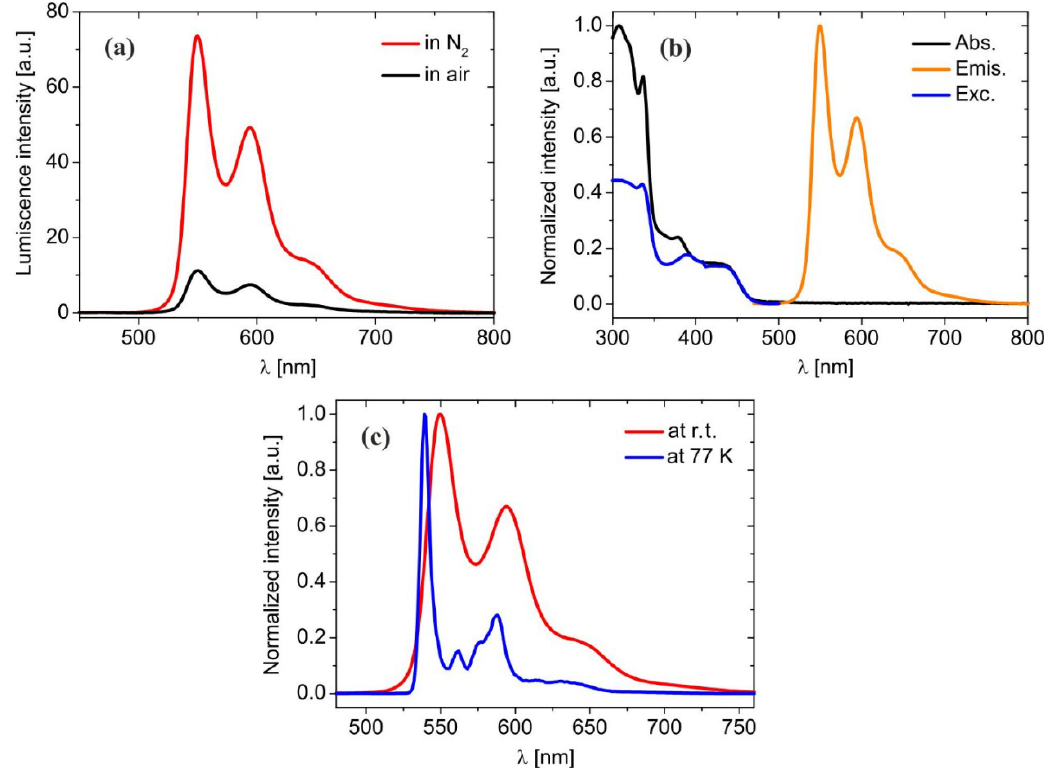
Figure 9. Emission spectra of aerated and deoxygenated solutions of 2 ( a ) in DCM recorded at λ exc = 412 nm; ( b ) comparison of the absorption, emission, and excitation spectra (λ = 550 nm) of 2 in DCM at r. t.; ( c ) comparison of emission spectra of 2 at r. t. and at T = 77 K in a frozen 2-MeTHF